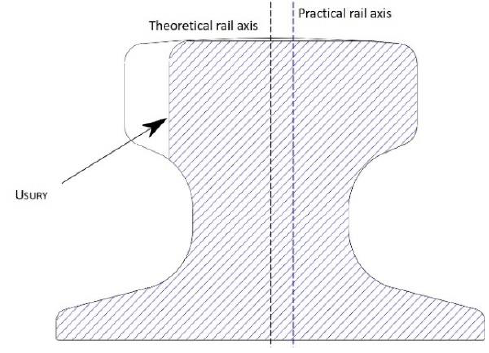
Figure 17. Theoretical and practical rail